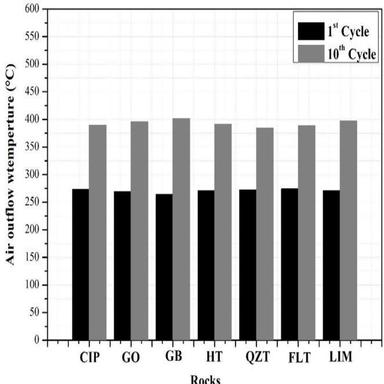
5. Air outflow temperature after the 1st and 10th thermal cycles for each type of rock.